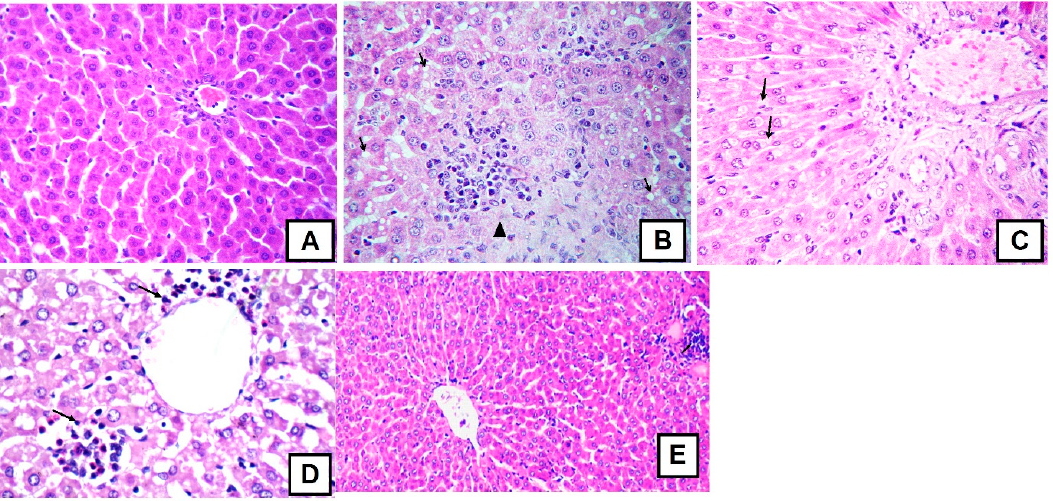
Figure 11. Representative photomicrographs of cross sections from six rat livers (staining with hematoxylin and eosin, 400×); ( A ) Liver of healthy rats with normal hepatocytes arranged in hepatic cords radiating from the central vein with normal portal area, central vein and normal ducts; ( B ) Liver of D-galactosamine treated rats showing focal hepatic necrosis infiltrated by mononuclear cells (arrow head) with microsteatosis of the adjacent hepatocytes (arrows); ( C ) Liver of extract (100 mg/kg) treated rats with minute fibrous strands in portal area and interlobular tissue with reversible degenerative changes mainly vacuolar degeneration in the hepatic cells (arrows); ( D ) Liver of extract (200 mg/kg) treated rats showing portal inflammation (arrows) but no steatosisornecrosis; and, ( E ) Liver of silymarin extract (100 mg/kg) treated rats showing partial improvement but some monocellular infiltration.